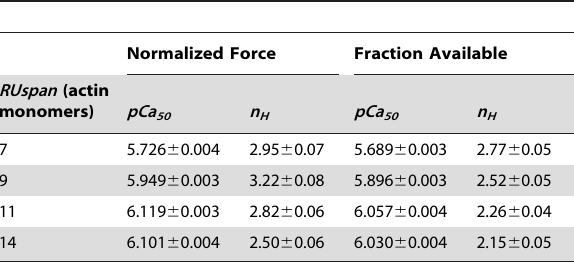
Table 1. Values of RU span compared to physiological thin filament structures.